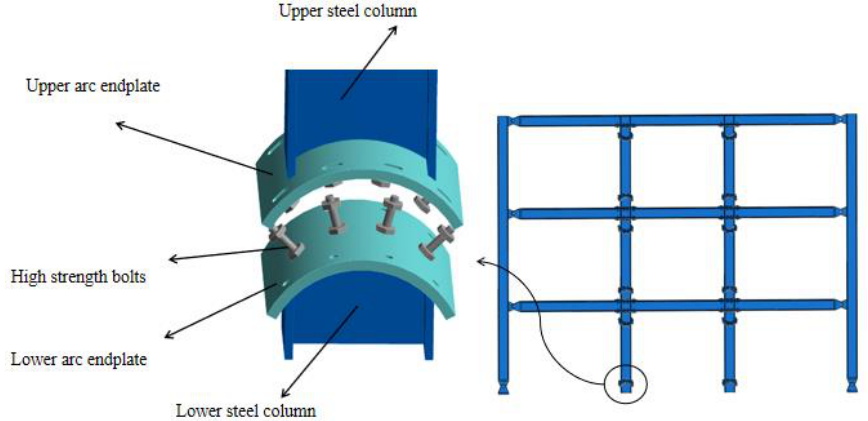
Figure 1. Schematic diagram of column base connection.